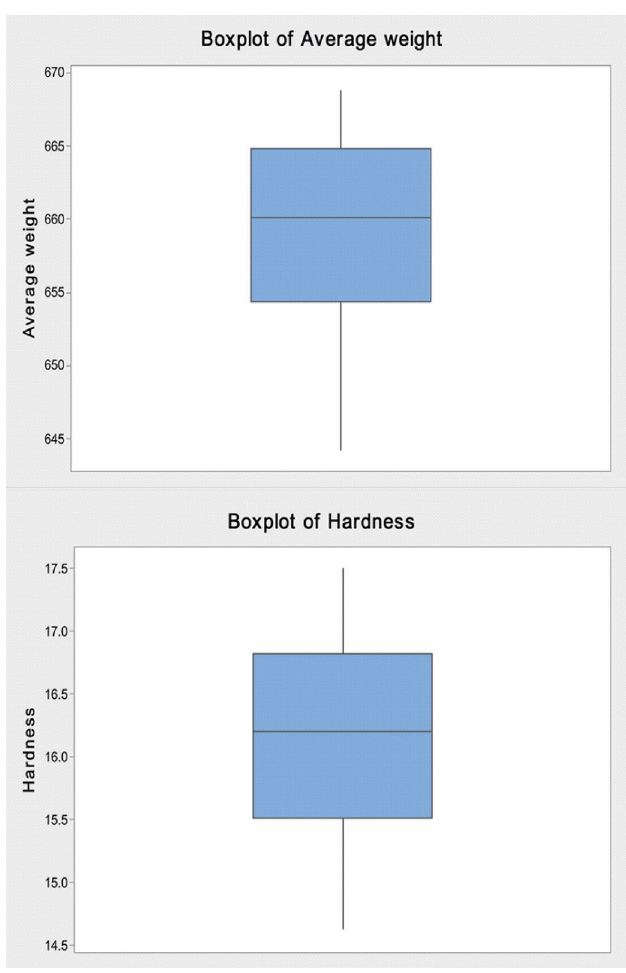
FIGURE 1 - Box Plot diagram showing the pattern of data distribution for average weight and hardness as part of IPC tests during the compression